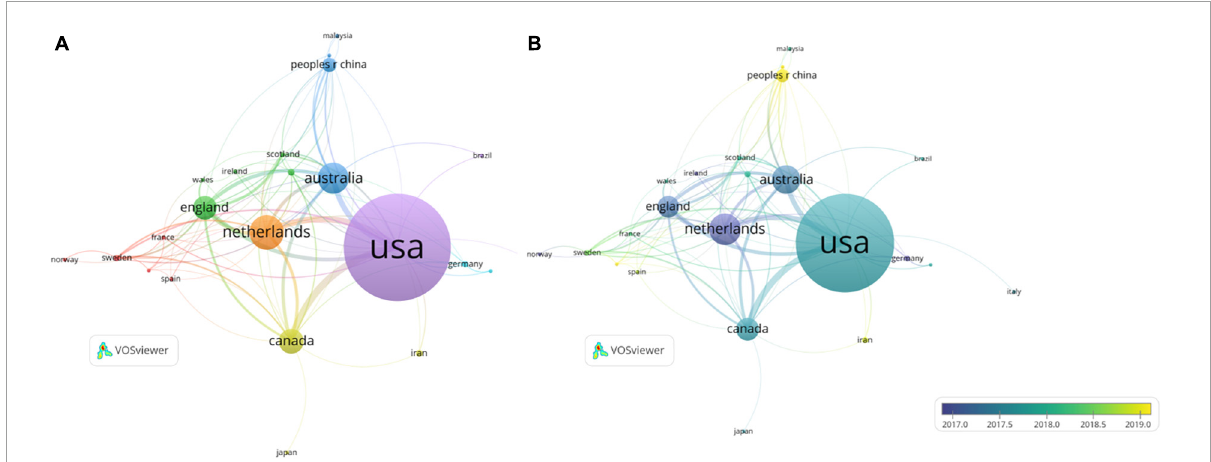
FIGURE4 Co-authorship analysis of countries in the area. (A) Co-authorship network diagram between countries with over five documents. (B) Co-authorship overlap diagram between countries with over five documents.